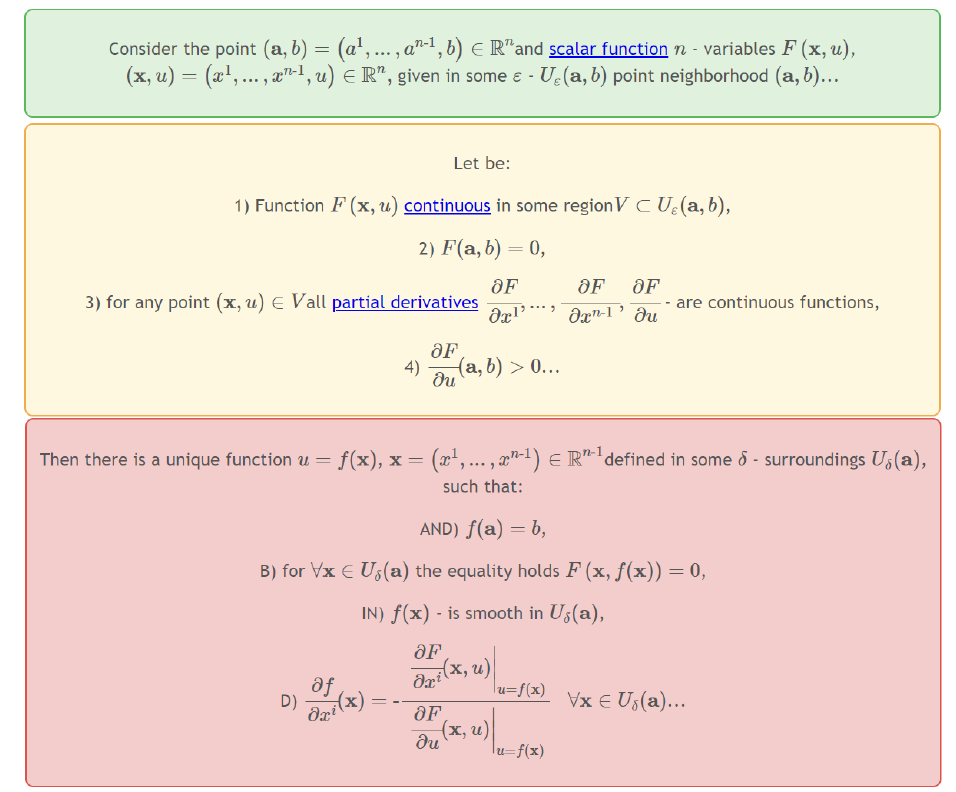
Fig. 1. Formulation of the theorem in the form «traffic light» in the DLS